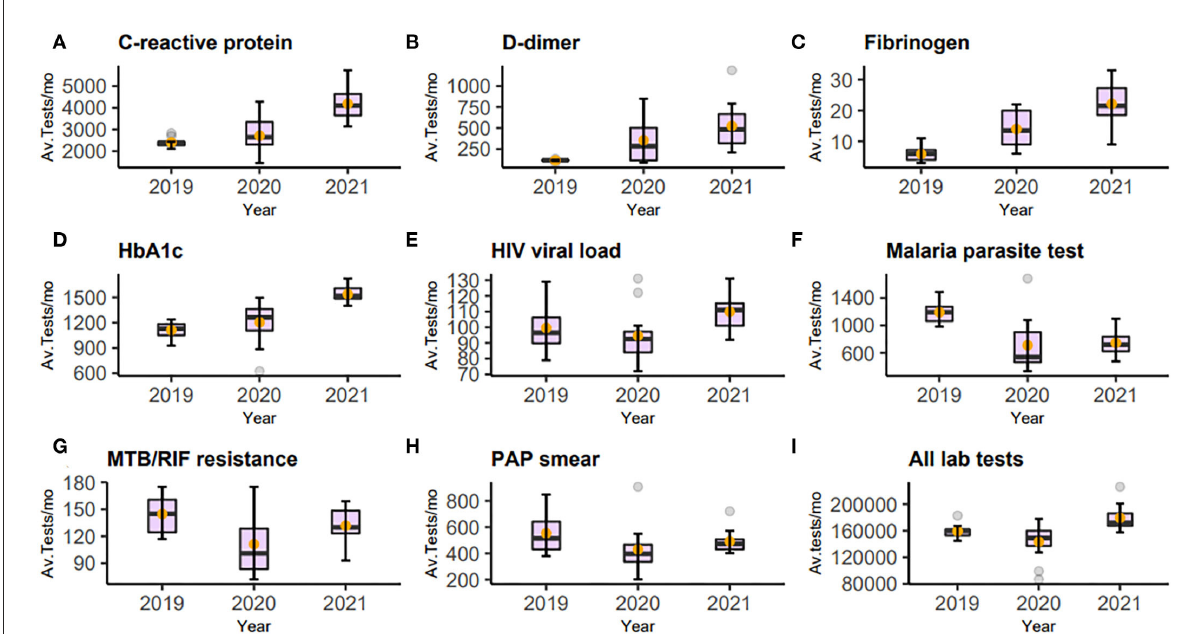
FIGURE2 Figure of box-and-whisker plot (A–I) representing C-reactive protein, D-dimer, fibrinogen, HBA1c, HIV viral load, Malaria parasite test, MTB/RIF, PAP smear, and all laboratory tests. Each panel shows the changes in average tests per month (Av. Tests/mo) from 2019 to 2021 The mean is represented by the orange dot. The statistical summaries of these and other tests not plotted are shown in Table